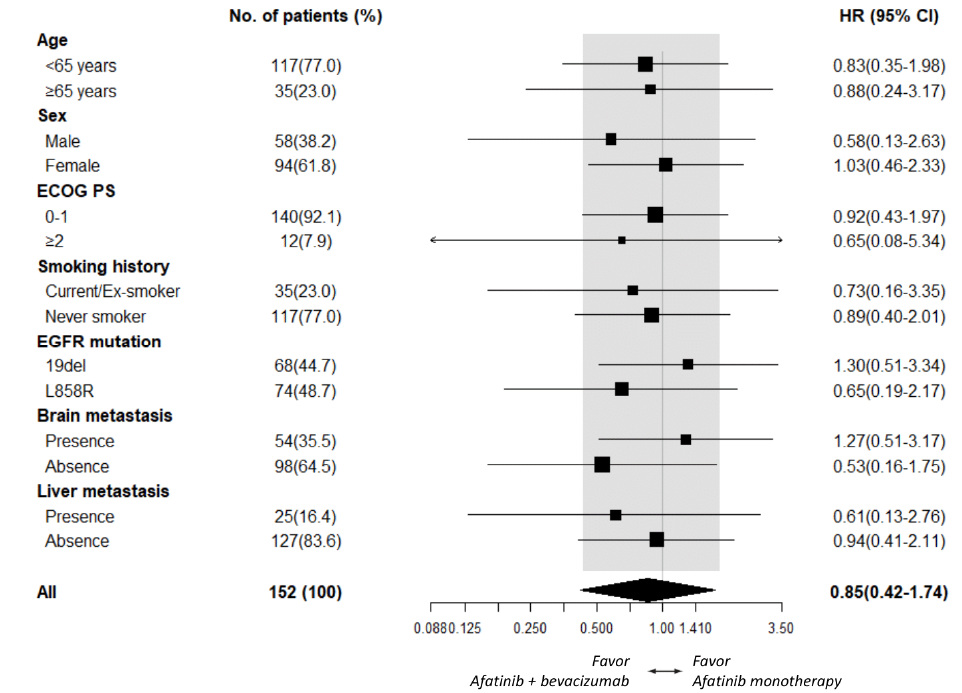
Figure 3. Subgroup analysis of OS between the afatinib plus bevacizumab and the afatinib mono- therapy groups.